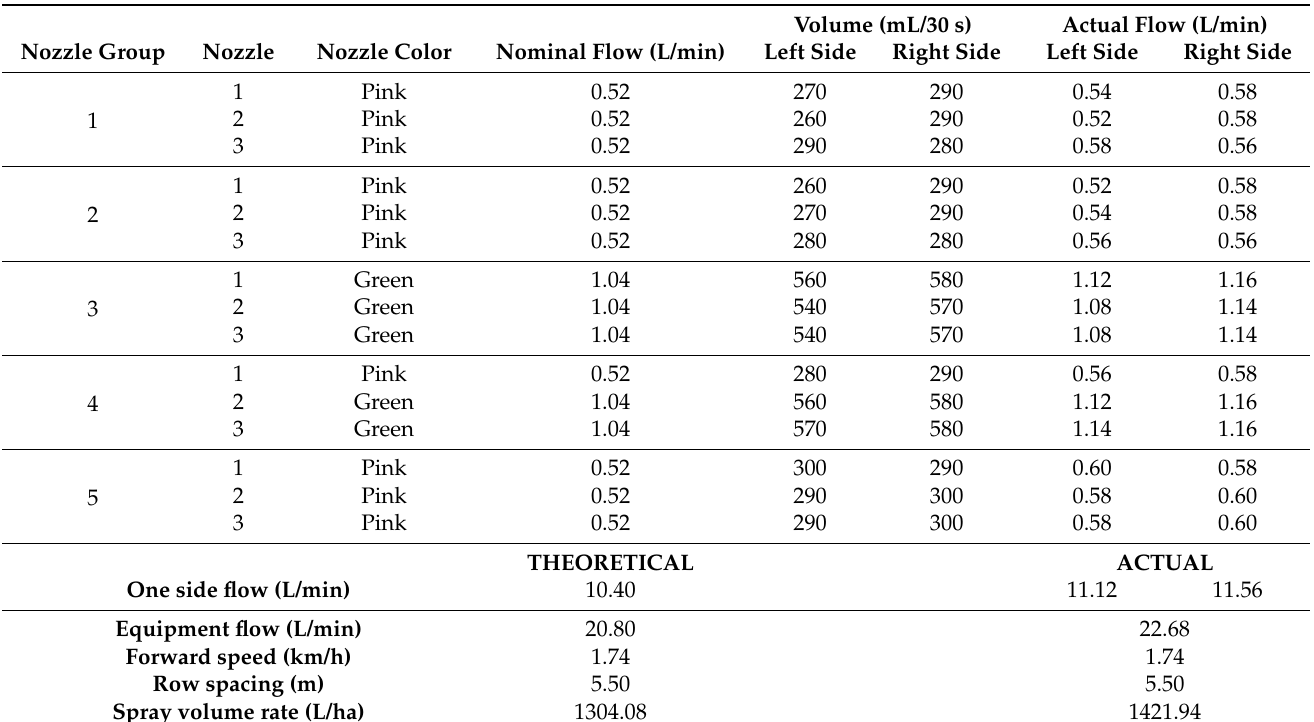
Table A6. Selection and calibration of nozzles for the T sprayer, with the following configuration: No adjusted to the vegetation/High & Low fan speed/Low spray volume rate/Drift-reducing nozzles (Coarse)/Pressure: 9